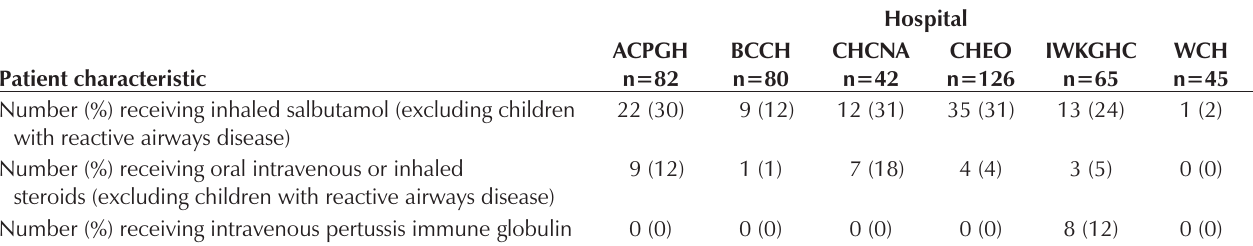
Erythromycin preparations, erythromycin dose and length of erythromycin course of 439* children admitted to six tertiary care hospitals with a primary admission diagnosis of pertussis Hospital ACPGH Patient characteristic Number (%) receiving erythromycin before or during hospitalization Number (%) receiving correct erythromycin dose in hospitals † Percentage receiving an estolate preparation of erythromycin Percentage receiving erythromycin course of 10 days or more *Sample size does not total 440 because of missing values; † 40 to 50 mg/kg/day to a maximum of 1 g/day. ACPGH Alberta Children’s Provincial General Hos- pital, Calgary, Alberta; BCCH British Columbia’s Children’s Hospital, Vancouver, British Columbia; CHCNA Children’s Health Centre of Northern Alberta, Edmonton, Alberta; CHEO Children’s Hospital of Eastern Ontario, Ottawa, Ontario; IWKGHC Izaak Walton Killam-Grace Health Centre, Halifax, Nova Sco-